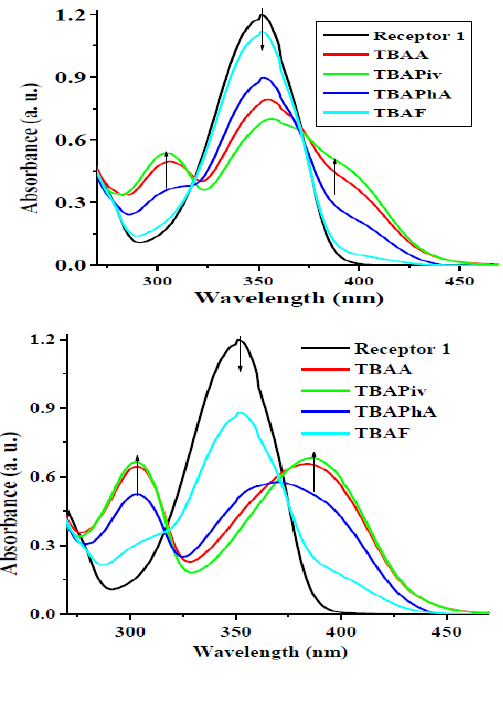
Figure 32: Change of absorption spectra of 35 upon addition of different tetrabutylammonium carboxylate and fluoride salts: (a) 1 equivalent; (b) 4 equivaLents in acetonitrile. (adapted from ref.